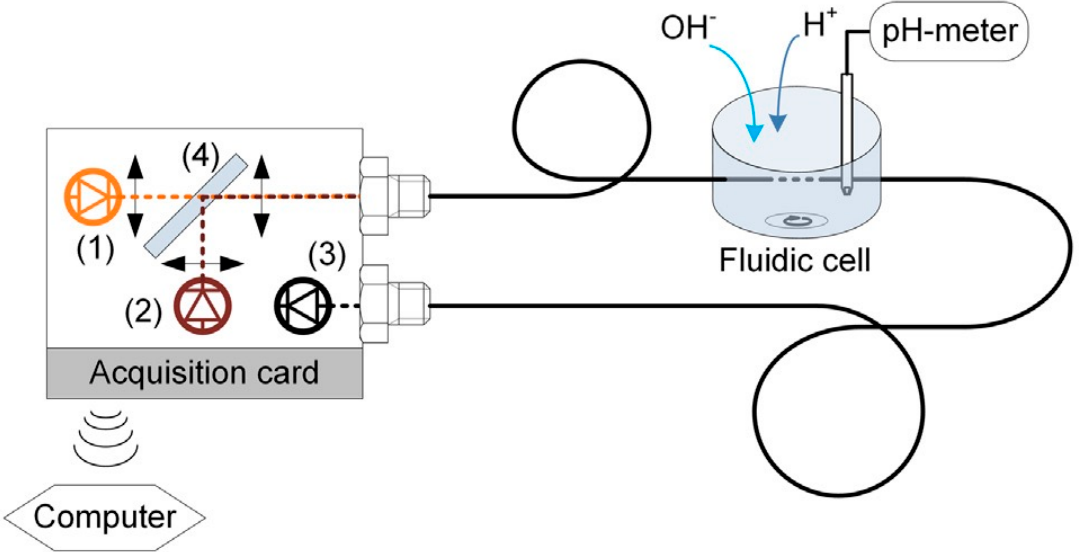
Figure 6. The specific structure of optical fiber pH sensor and its experimental design. ( 1 ) Signal light source ( 2 ) referred light source ( 3 ) photodiode and ( 4 ) dichroic mirror, reprinted with permission from reference [83]. (Copyright, Elsevier, 2014).